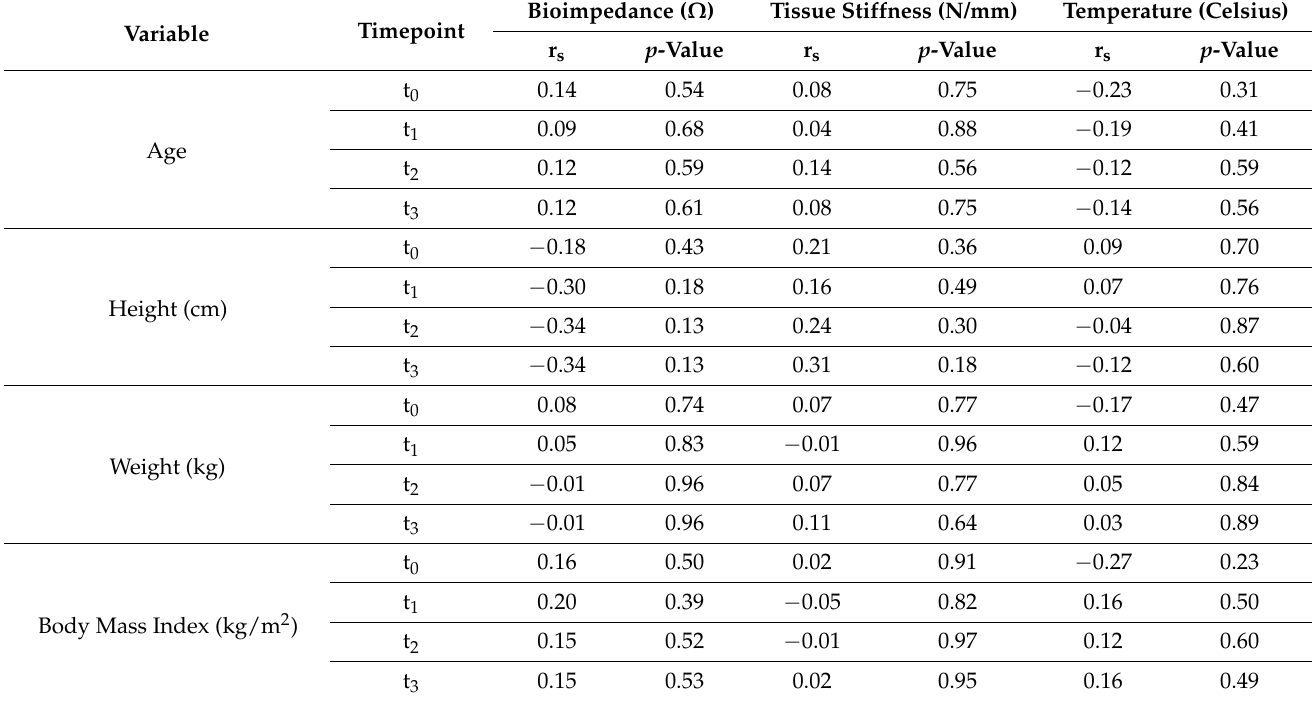
Table 5. Correlations between